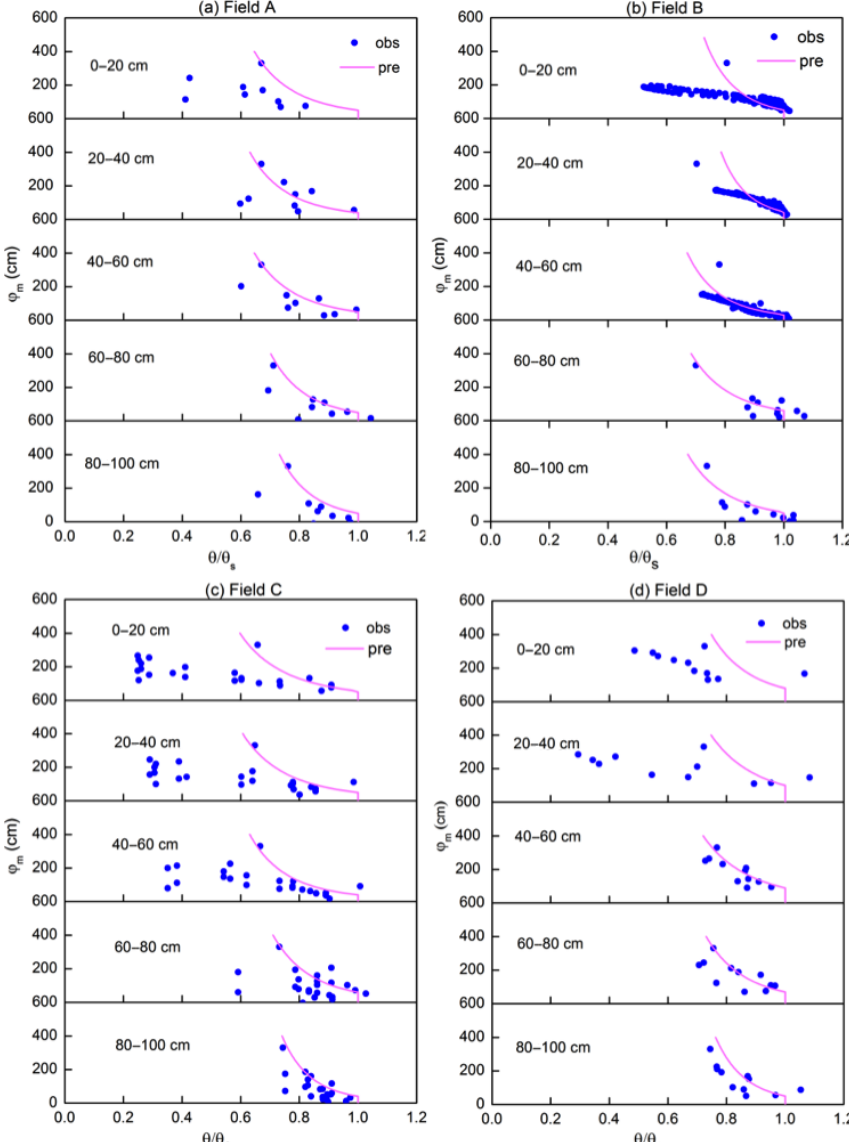
Figure 9. Soil moisture characteristic curves of five soil layers in the experimental fields. The pink line is the fit with the Brooks–Corey